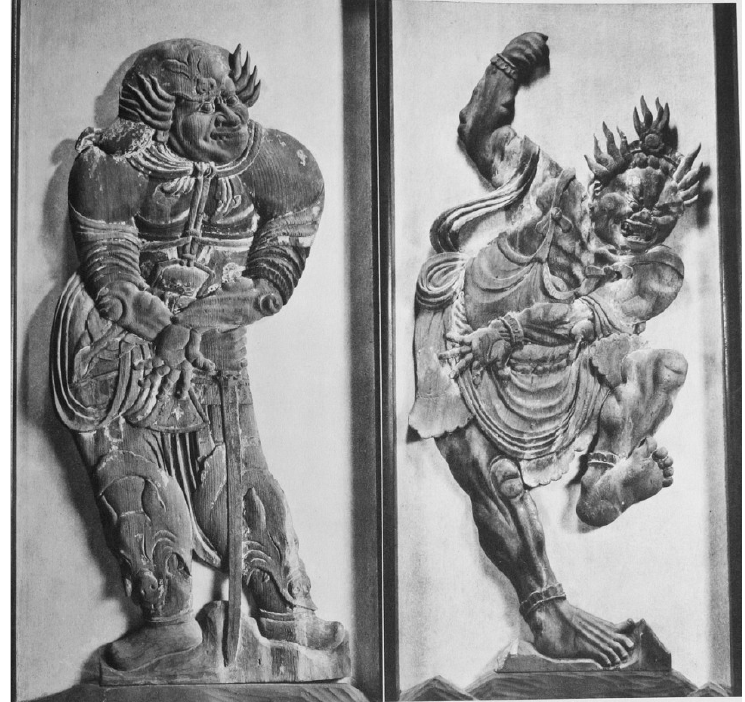
Figure 8. Eleventh-century relief carvings at the National Treasure Hall of K ō fukuji Temple, Nara, of two of the Twelve Divine Generals who accompany and guard the Master of Medicine Buddha (Yakushi Nyorai). The figure on the right, named Mekira today, likely served as the model for Hasegawa’s Nomi no Sukune depiction. Photograph by Sakamoto Manshichi, published in Nihon bijutsu zensh ū vol. 3 (T ō to Bunka Koeki Kabushikigaisha, 1953), reprinted from Wikimedia Commons. Image in the public domain, https://commons.wikimedia.org/wiki/File:Twelve_Heavenly_Generals_Relief.JPG (accessed on 28 August 2021).